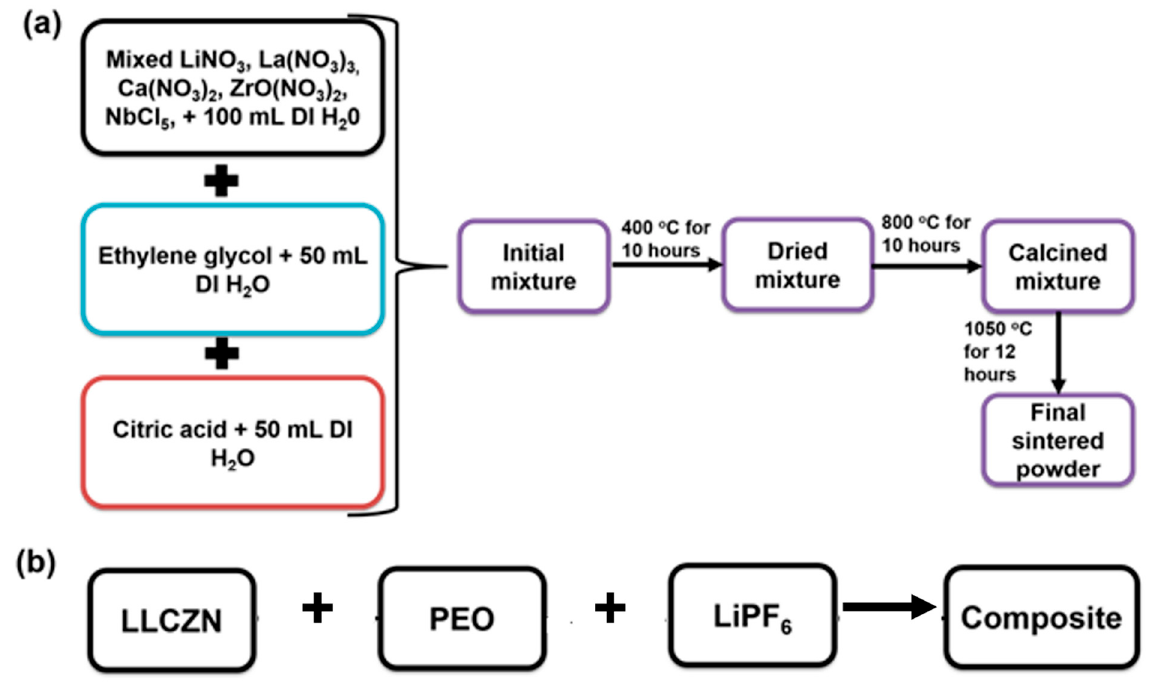
Figure 1. Schematic representation for the synthesis of ( a ) LLCZN powder via sol–gel method and ( b ) composite LLCZN/PEO/LiPF 6 in a ratio of 1:1:1 by weight.